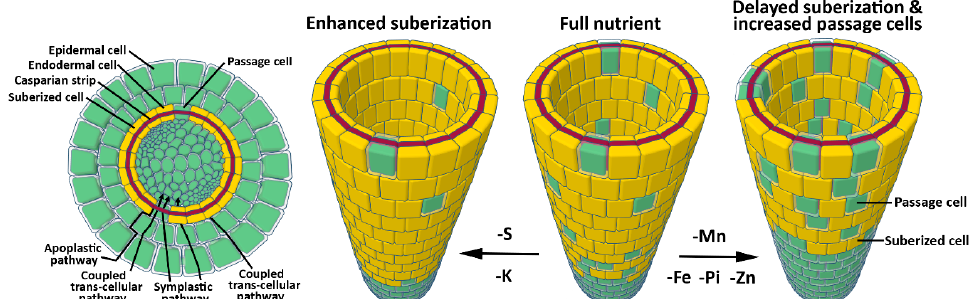
Figure 1. Plasticity in the permeability of endodermal cell walls in response to nutrient imbalance. ( Left Panel) Cellular schematic cross section of a fully differentiated Arabidopsis root. Suberized endodermal cells (yellow) and the lignified endodermal Casparian strip (red) block nutrient transport via the apoplastic and coupled-trans-cellular pathways. Passage cells are unsuberized endodermal cells that allow symplastic and coupled trans-cellular transport. ( Right Panel) Magnified view of the endodermal cell layer under varying nutrient availability. K and S deficiency causes an increase in suberization, while deficiency in Fe, Zn, and P causes a delay in suberization and increased